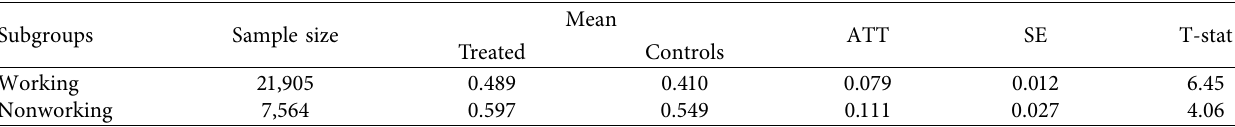
Table 7: ATTestimates for subgroups of women respondents: the treatment effects of having grandparents as the primary-care provider for the first child on having the second